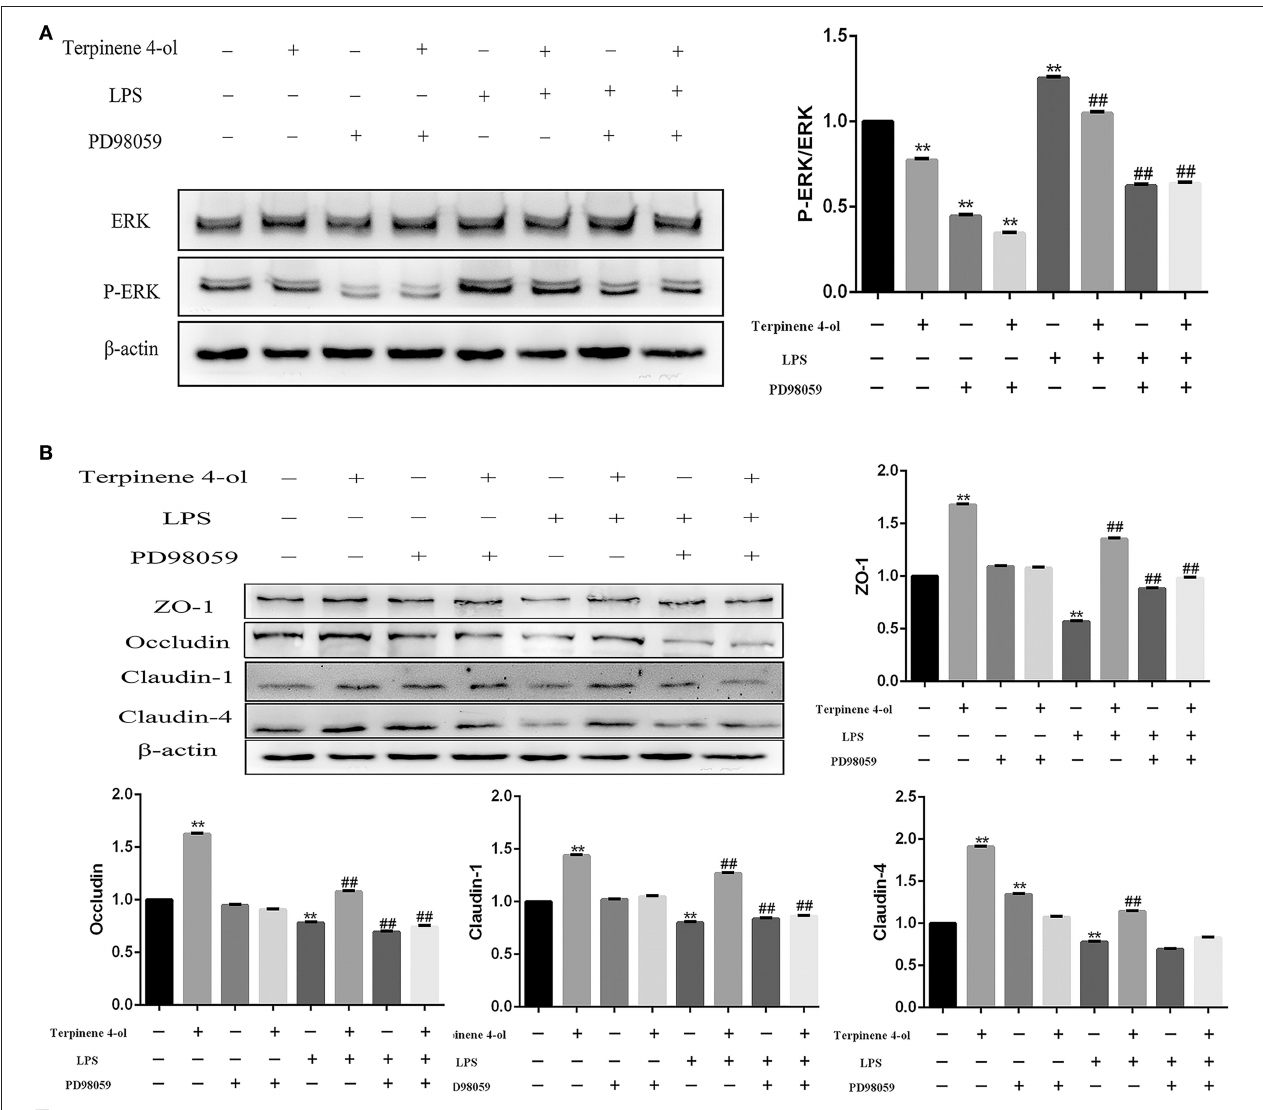
FIGURE 6 | Effect of ERK phosphorylation inhibition on tight junction (TJ) protein expression. (A) The expression of phosphorylated ERK and (B) TJ proteins were detected in cells pretreated with the ERK inhibitor PD98059 (50 µ M) for 1h before treatment with TER or LPS. ** and ## display similar means with above